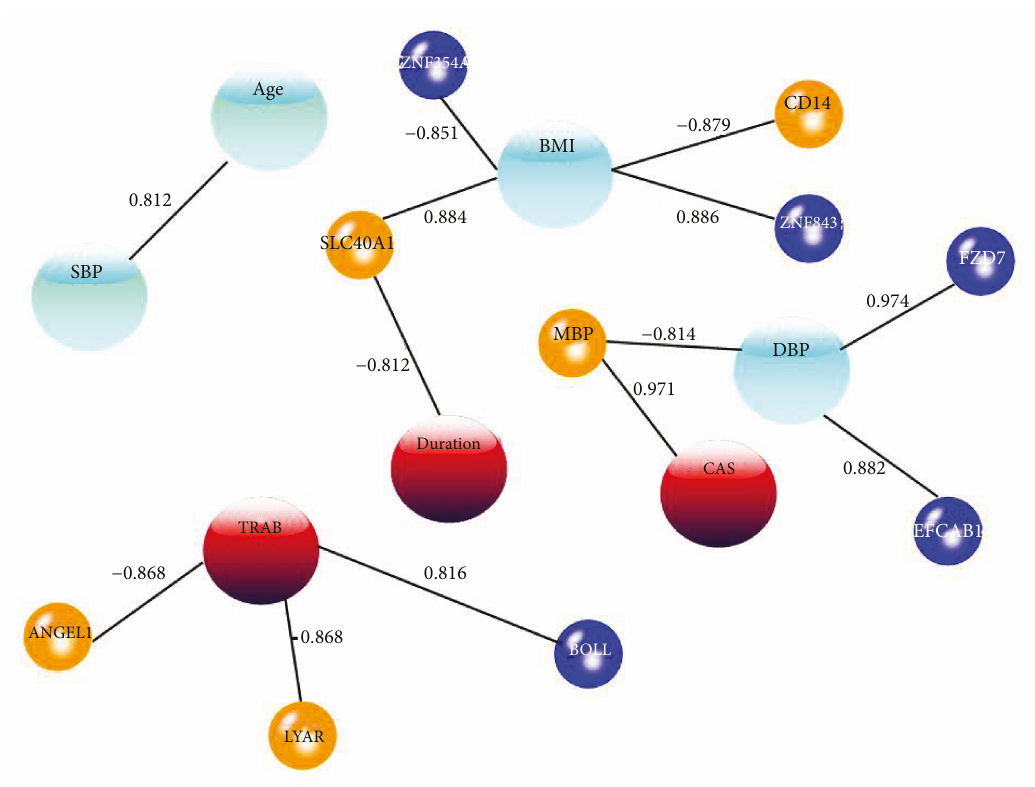
Figure 4: Association between candidate genes and clinical phenotypes in a network. The small orange circles indicate HMGs, whereas the small blue circles indicate LMGs. Age, SBP, BMI, and DBP are general phenotypes shown in large light blue circles. TRAb, duration, and CAS are GO-related clinical phenotypes shown in deep red